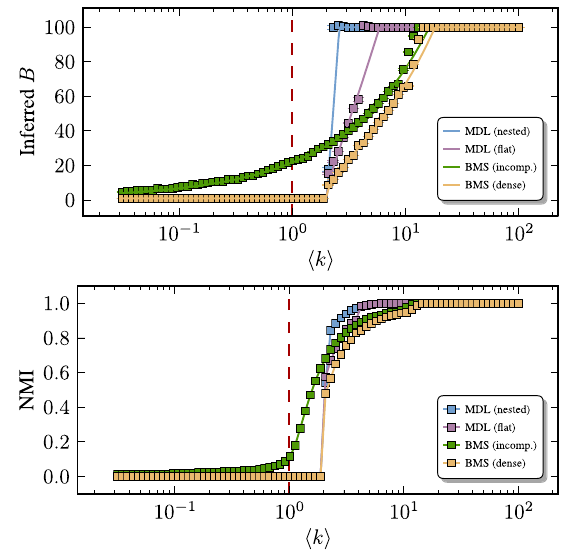
FIG. 2. Model selection results for a PP model with N ¼ 10 4 , B 100 , and fully isolated blocks ( c ¼ 1 ), using the model- true ¼ selection criteria described in the text. The top panel shows the inferred value of B versus the average degree h k i in the network. The solid lines show the theoretical value according to each criterion, and the data points are direct optimization of the corresponding quantities for actual generated network, averaged over 40 independent realizations. The bottom panel shows the normalized mutual information (NMI) between the inferred and planted partitions. The dashed line marks the threshold h k i ¼ 1 where inference becomes impossible for N → ∞